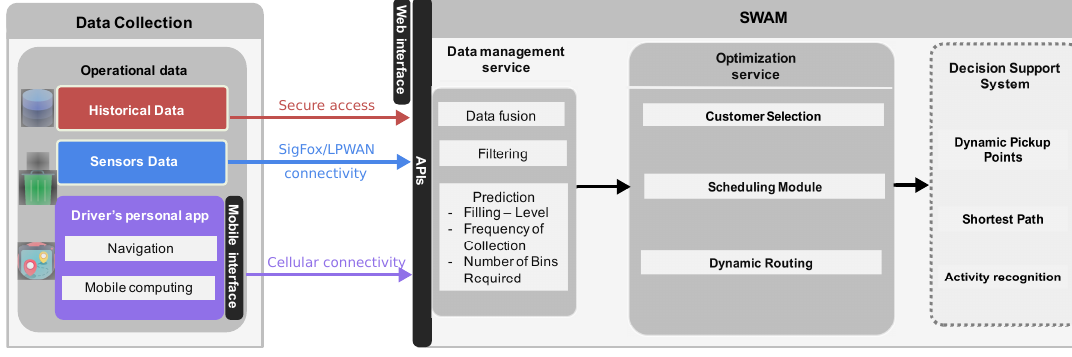
Figure 4. SWAM—High-level